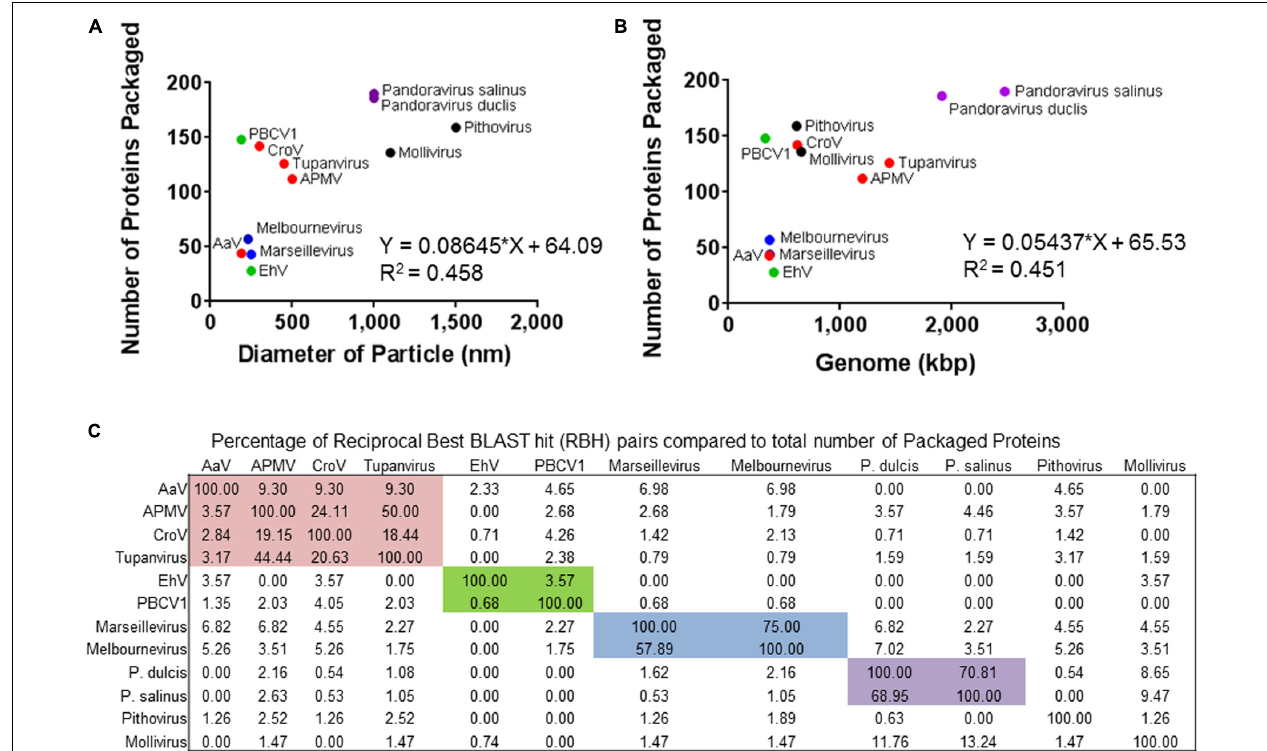
FIGURE 2 | Overview of the other proteomes of packaged proteins used in this study. The number of proteins packaged by each virus was compared to (A) diameter of the particle or (B) the genome size. (C) Percentage of total proteins packaged by the virus (rows) that share a reciprocal best BLAST hit pairs shared between each other (columns). Colored boxes represent the families of viruses. The colors of the icons or boxes indicate viral families with more than one representative: red = Mimiviridae , green = Phycodnaviridae , blue = Marseilleviridae , and purple = Pandoraviridae